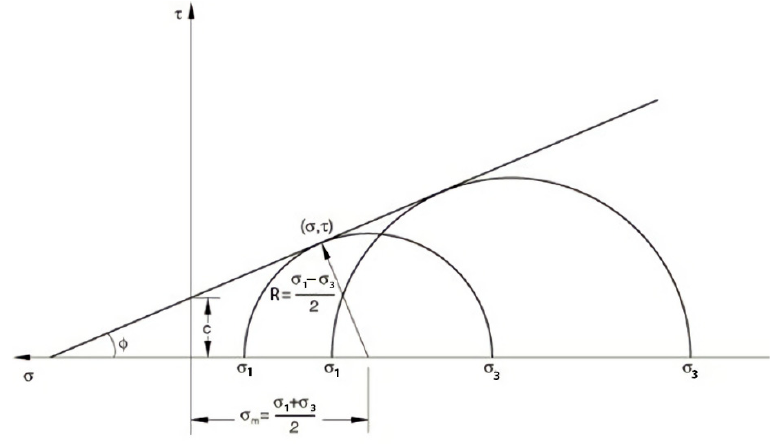
Figure 3. Mohr–Coulomb failure surface in the linear envelope in the Mohr diagram [28].